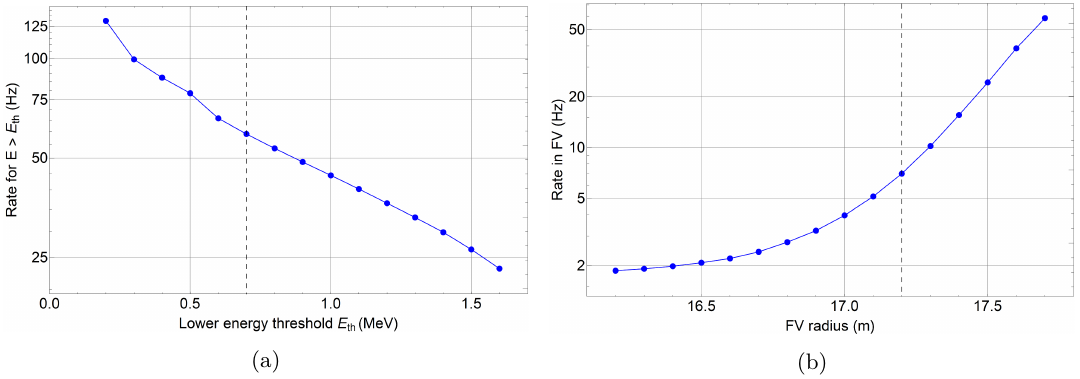
Figure 7. Full background simulation results with SNiPER including all materials composing the detector with the contaminations listed in table 1. (a) Singles event rate as a function of energy threshold in DV. About 60 Hz total singles rate is achieved with 0.7 MeV energy threshold (shown as dotted line). (b) Singles event rate with energy larger than 0.7 MeV as a function of the FV